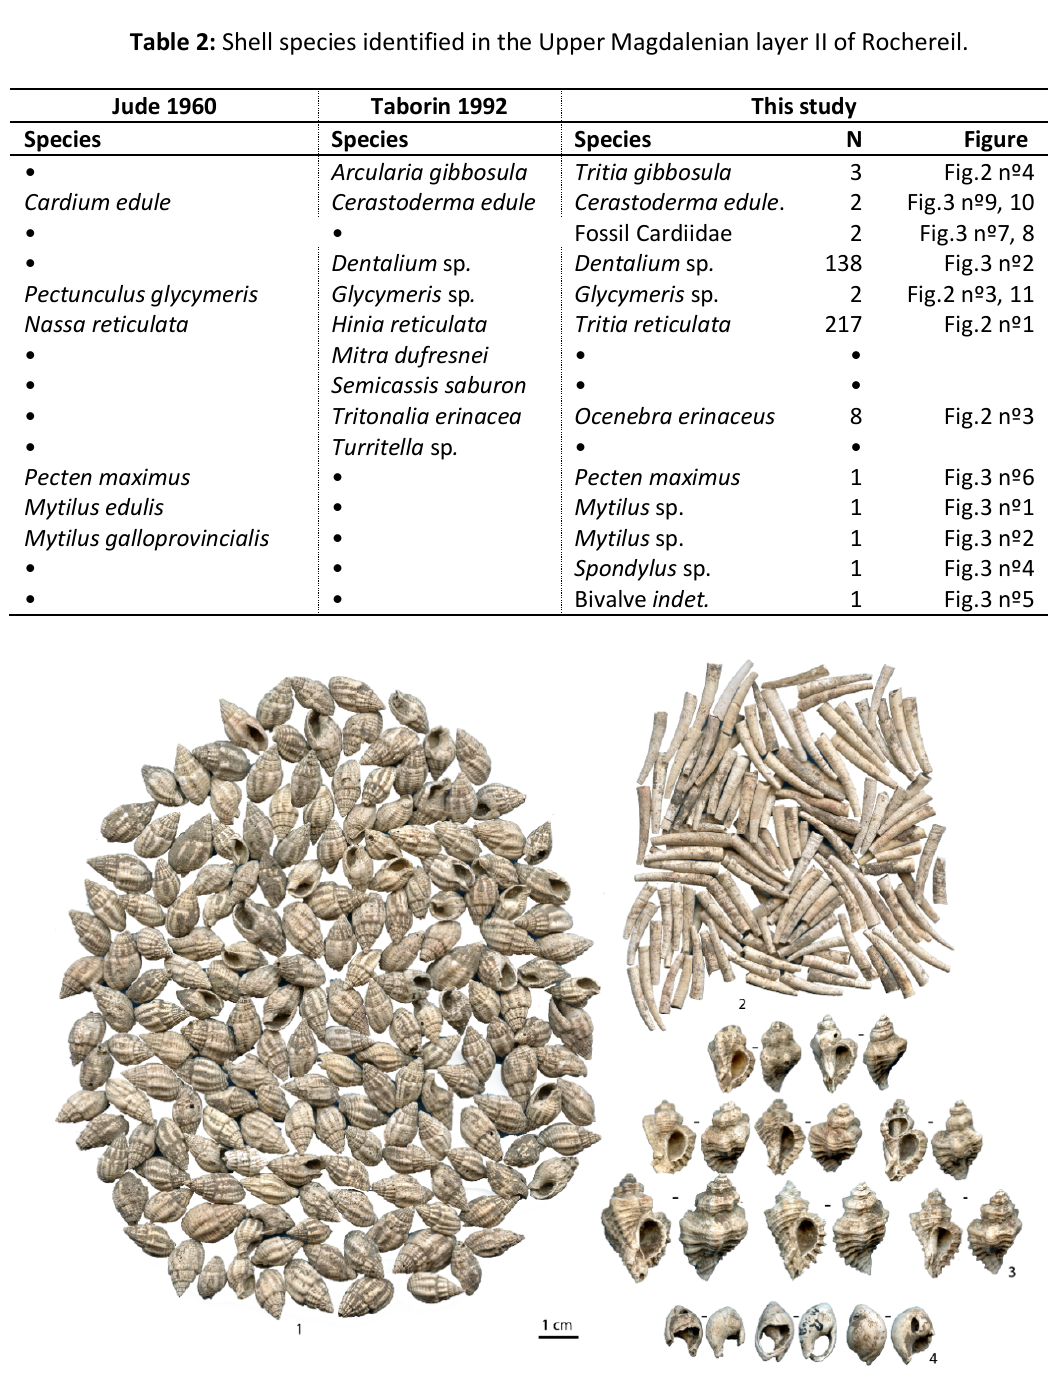
Figure 2: Gastropods and scaphopods recovered in the Upper Magdalenian from Rochereil. 1) Tritia reticulata , 2) Dentalium sp., 3) Ocenebra erinaceus , 4) Tritia gibbosula